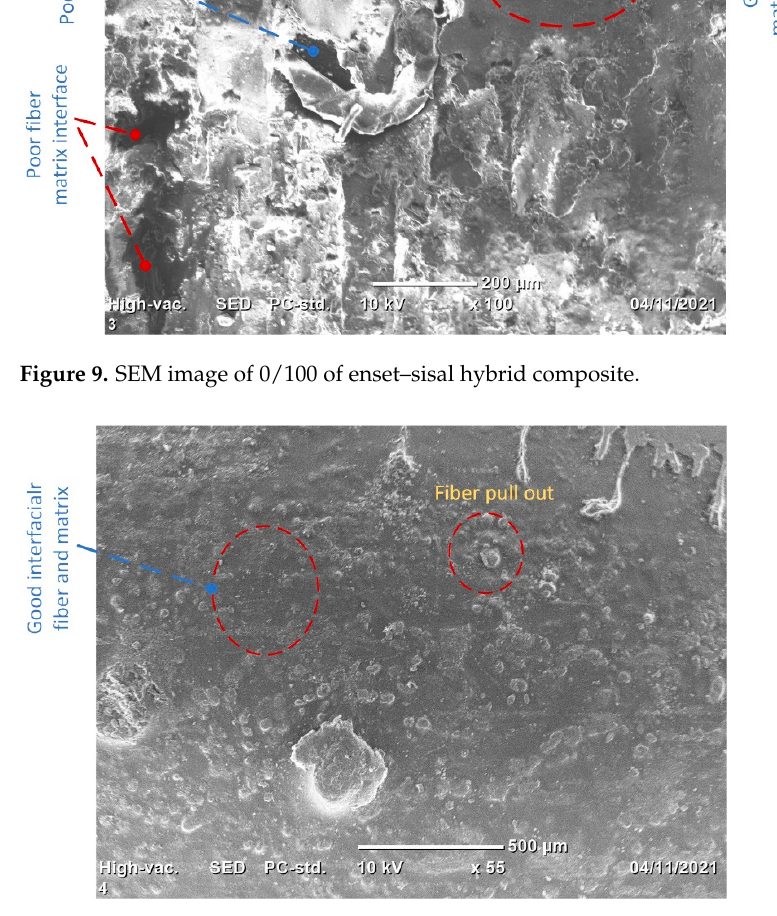
Figure 10. SEM image of 50/50 of enset–sisal hybrid composite.